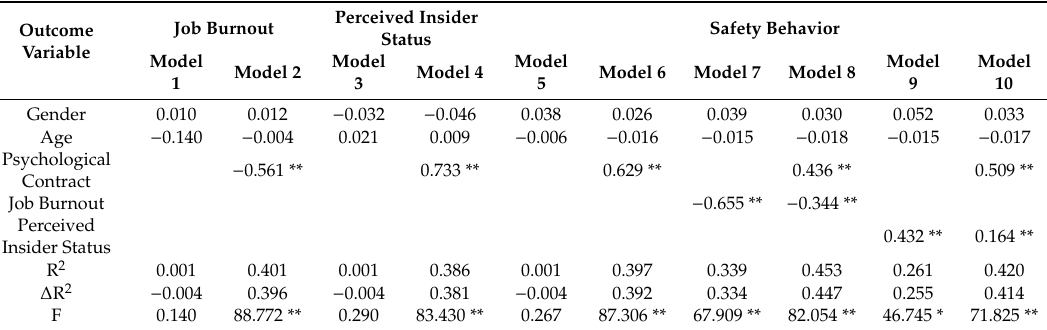
Table 6. Multiple linear regression analysis results of the variables.